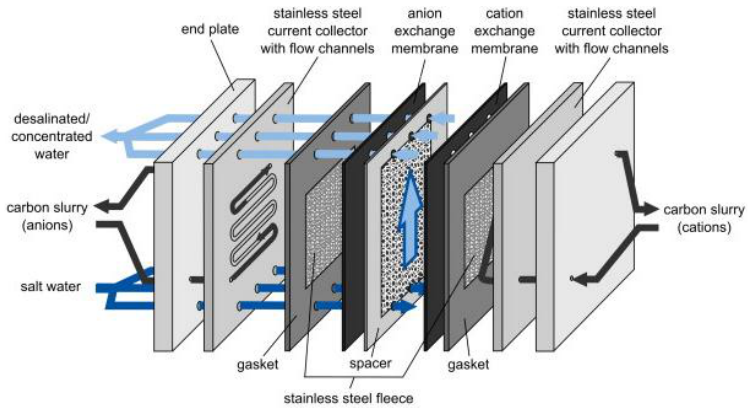
14 of 22 Figure 8. Schematic diagram of GAC (granular activated carbon)-MCDI as depicted by Bian et al. [124]. Reproduced with permission, copyright Elsvier, 2015.